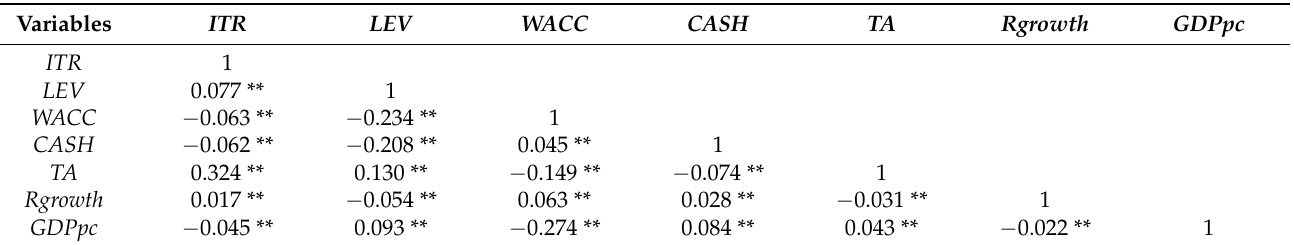
Table 5. Correlation matrix for the variables of